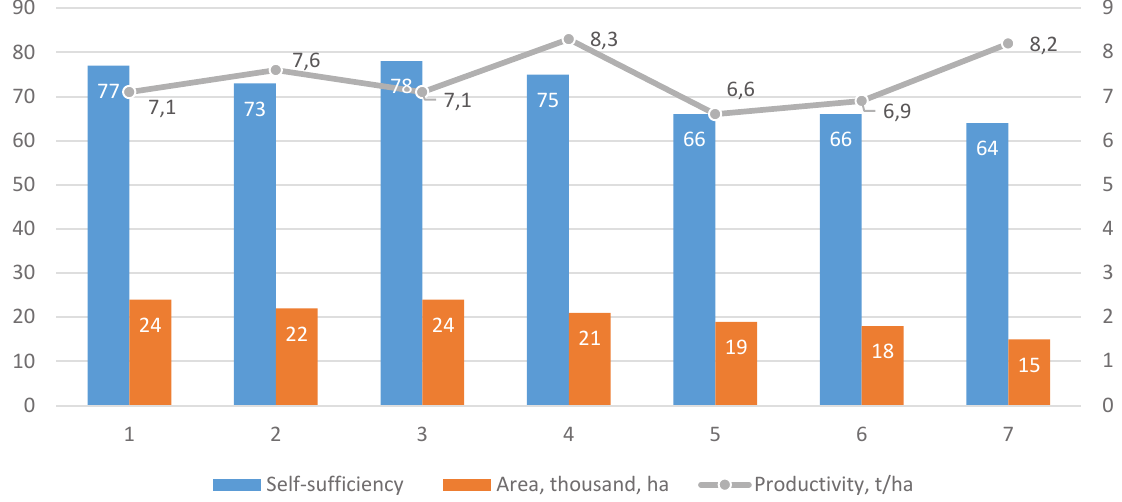
Figure 4. Main indicators of vegetable production in Georgia in the period